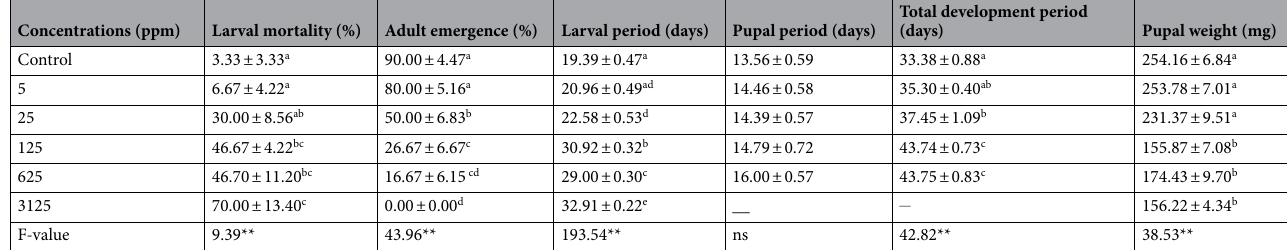
Table 1. Larval mortality, adult emergence, larval period, pupal period, total developmental period, pupal weight of S. litura when 6 days old instar larvae were fed on different concentrations of gallic acid. **Significant at 1%, ns Non-Significant. Values are Mean ± SE. Means followed by the same letter within the columns are not significantly different according to Tukey’s test at p ≤ 0.05.